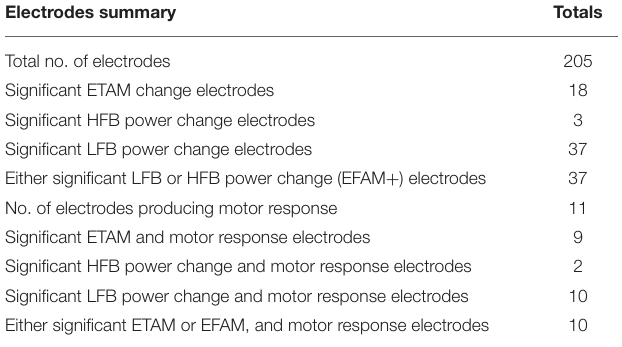
TABLE 4 | Electrodes summary.